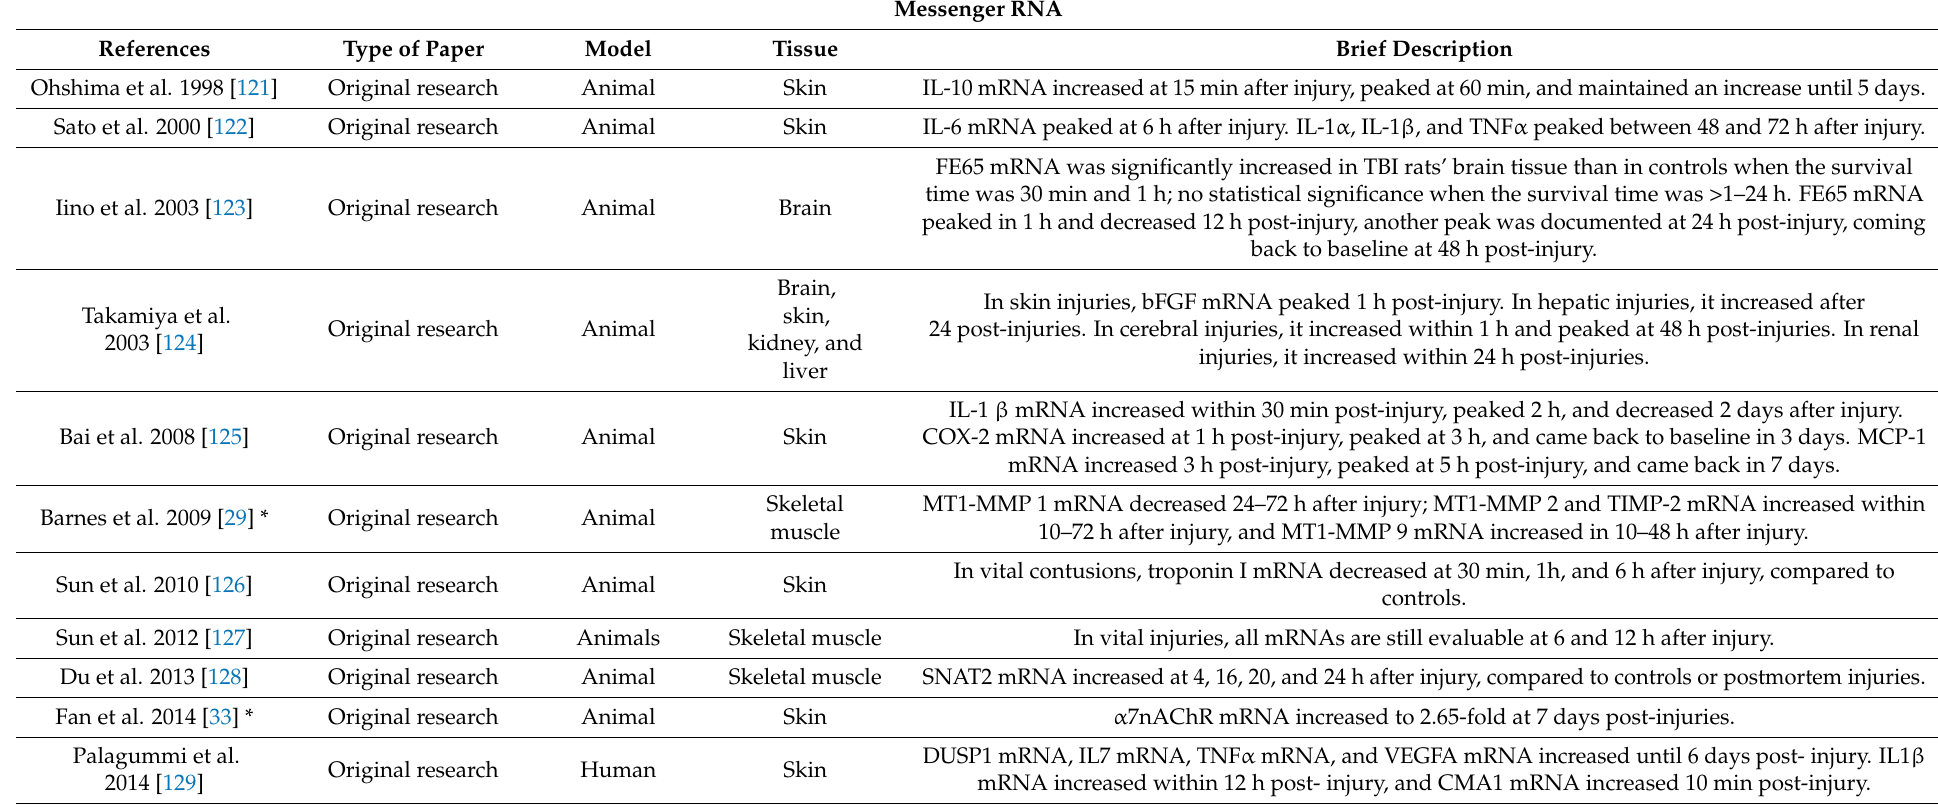
Table 3. The results of our review on mRNAs and miRNAs quantified for wound vitality evaluation (respectively, 20 and 21 papers). * α 7nAChR indicates α 7 nicotine acetylcholine receptor; IL, interleukin; MMP9, matrix metallopeptidase; TNF- α , tumor necrosis factor α ; TIMP-2, tissue inhibitor of